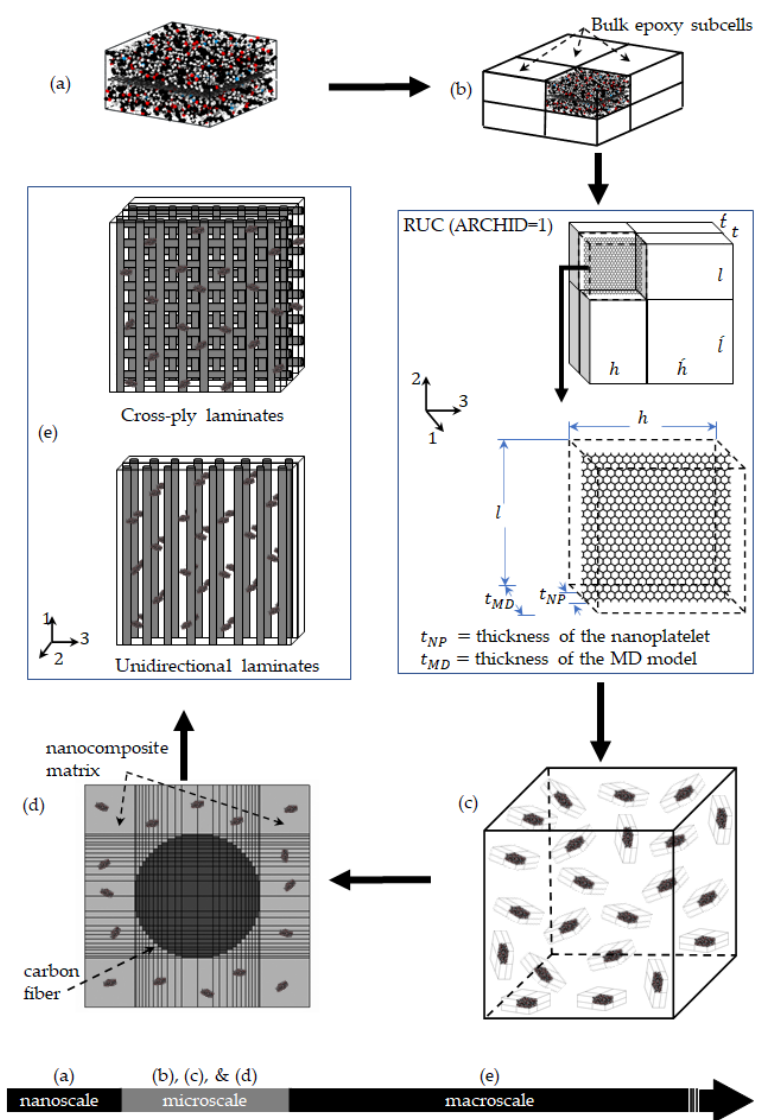
Figure 2. The multiscale modeling workflow; ( a ) MD model: Local interphase region of nano-